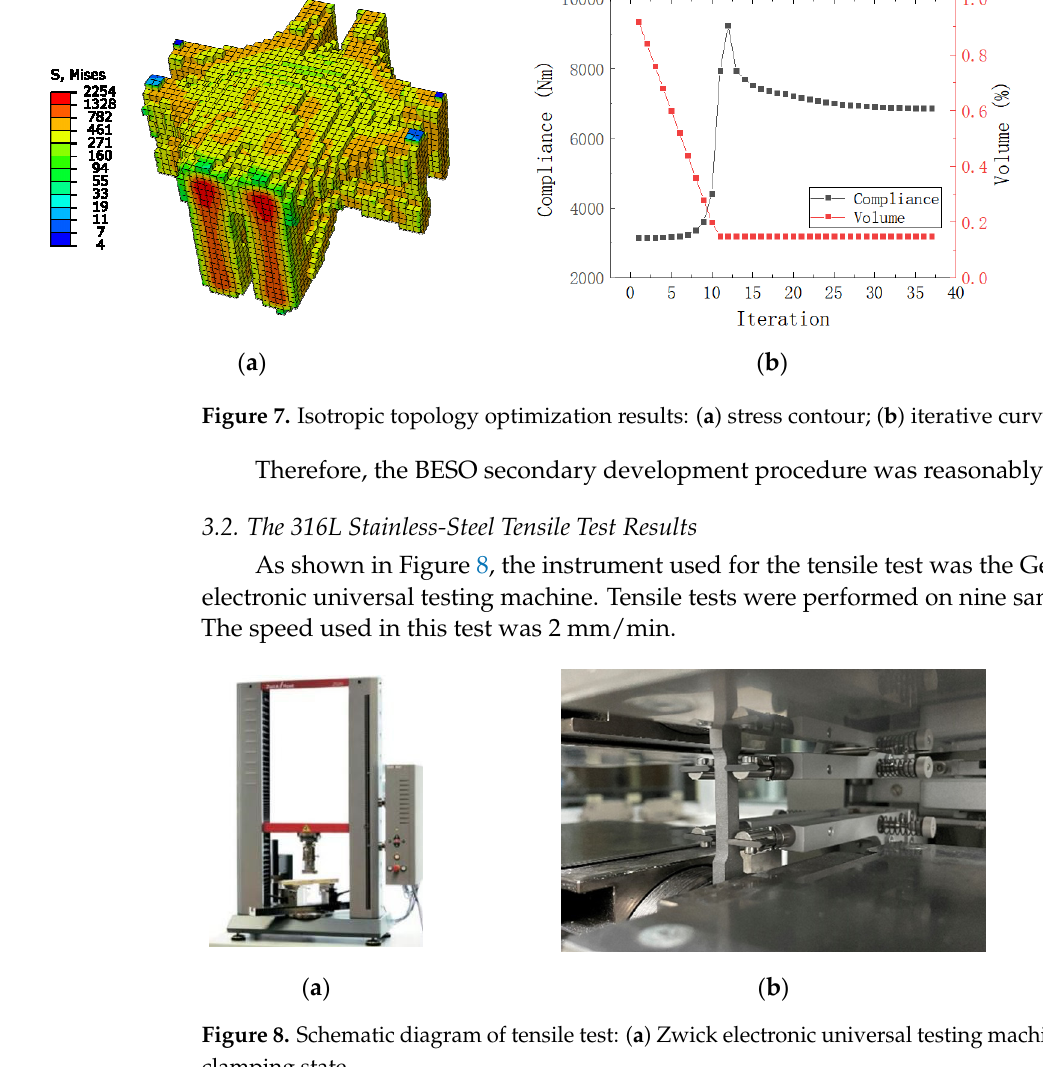
Figure 6. Initial shape and load layout of nodes (the green part is the design domain, the gray part is the ear plate area, the yellow arrow is the combined load of axial force and pressure, and the blue area is the binding boundary).